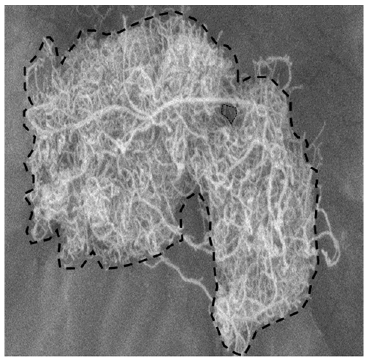
Figure 4. Enveloped boundary of VACNT.